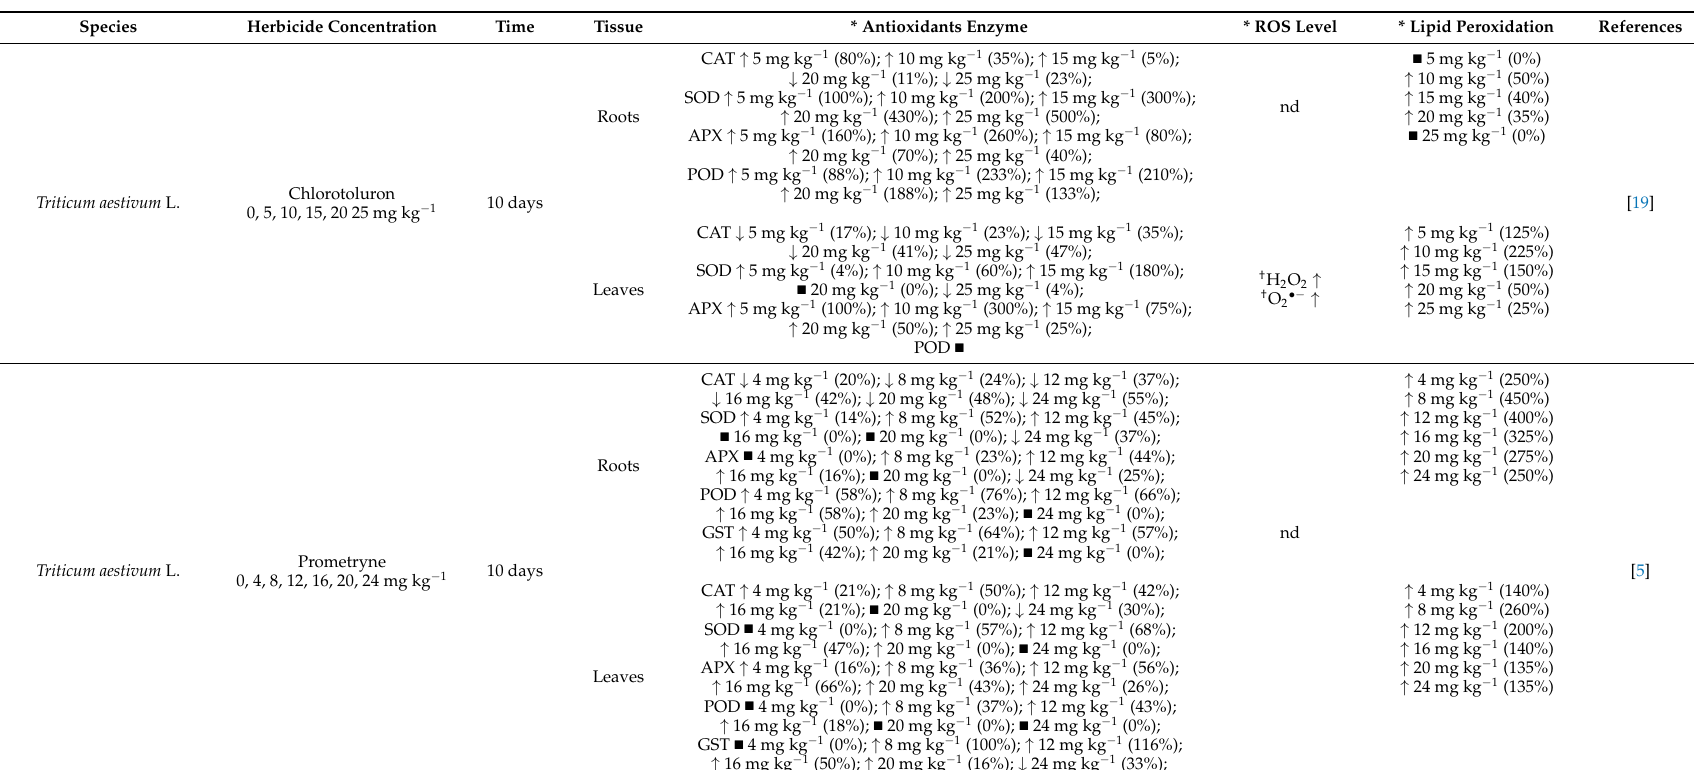
Table 2. Alterations in antioxidant enzyme activities, ROS level, and lipid peroxidation in different species after herbicide treatment. Species Herbicide Concentration Time Tissue